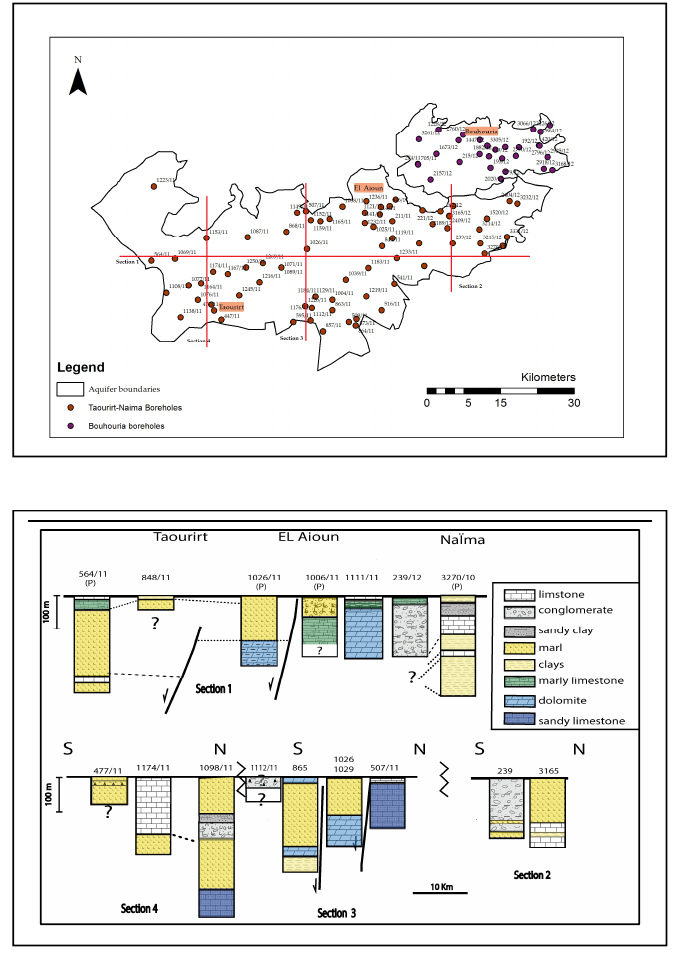
Figure 2. Hydrogeological sections in the Taourirt-Naima corridor [44].